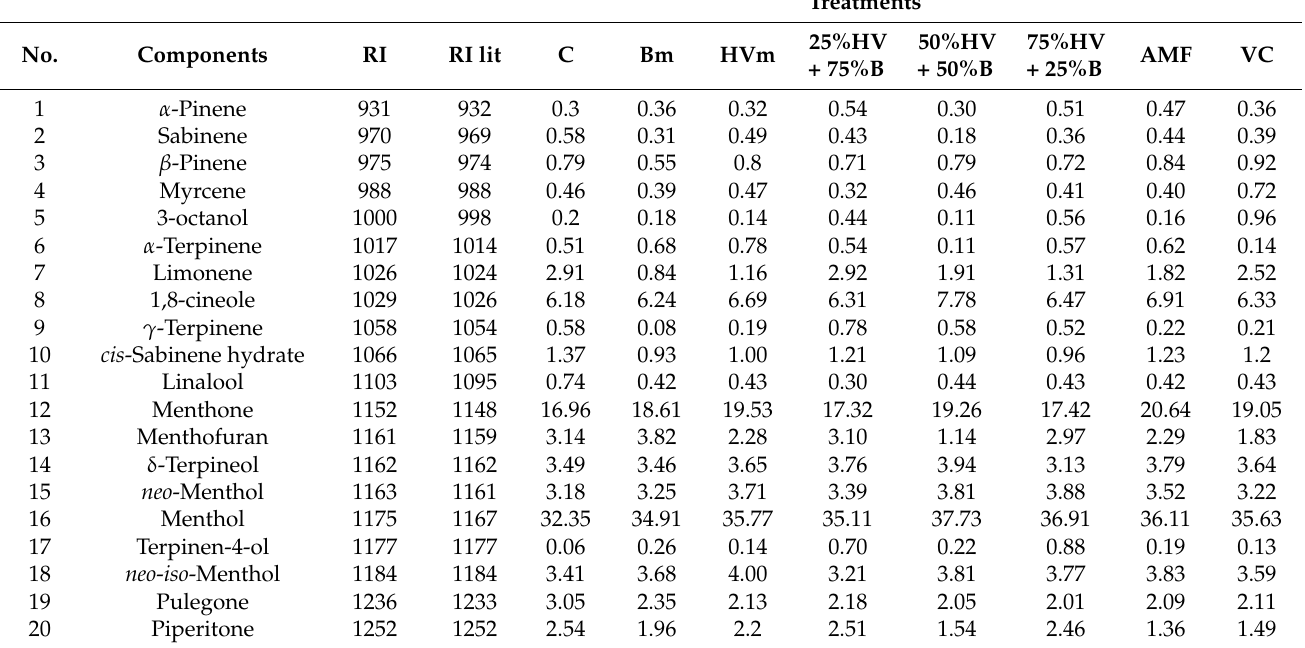
Table 2. The essential oil constituents of peppermint under different fertilizer sources (average of two years). Treatments